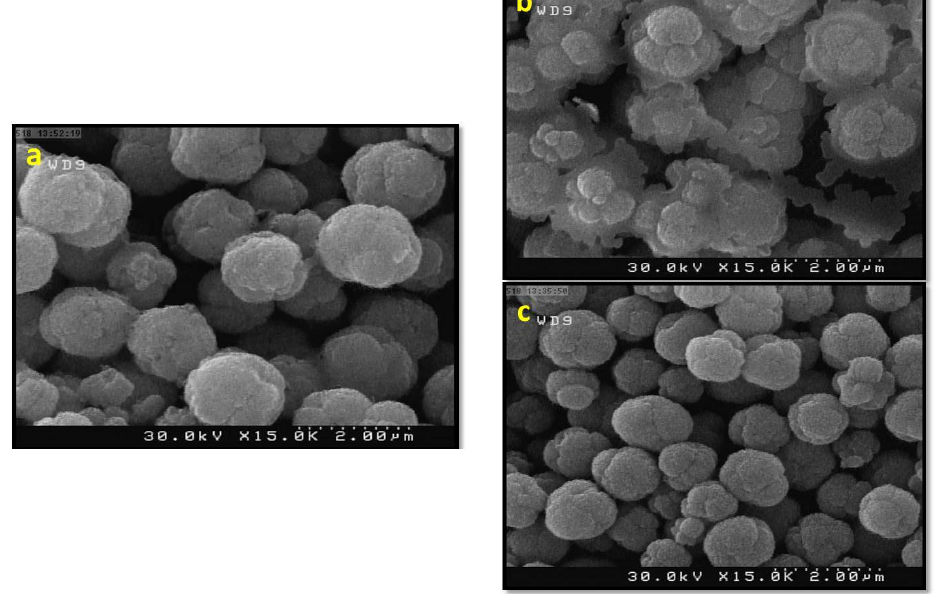
Figure 7. SEM images for the effects of surfactants and stabilizers on the final morphology of 3D CuO-ZnO hybrid hierarchical nanostructures. In the presence of ( a ) PEG 6000; ( b ) SDS and ( c ) CTAB. The use of SDS as the surfactant had different impacts (Z2 sample). It seems that SDS leads to the formation of dome-shaped with flat base microstructures (Figure 7b). Some relics of the flower like symmetry still remain. Also in comparison with the Z0 sample, the mean size of the